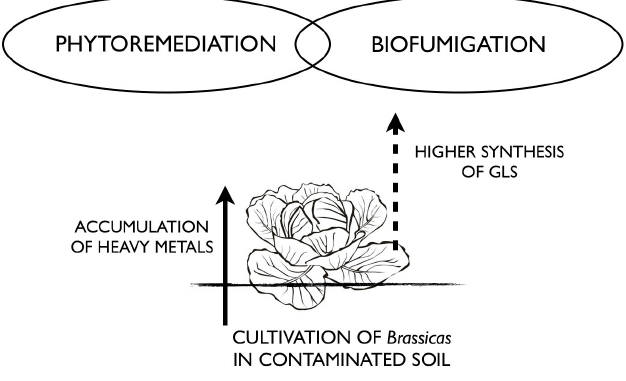
Figure 2. Diagram showing the combination of phytoremediation with